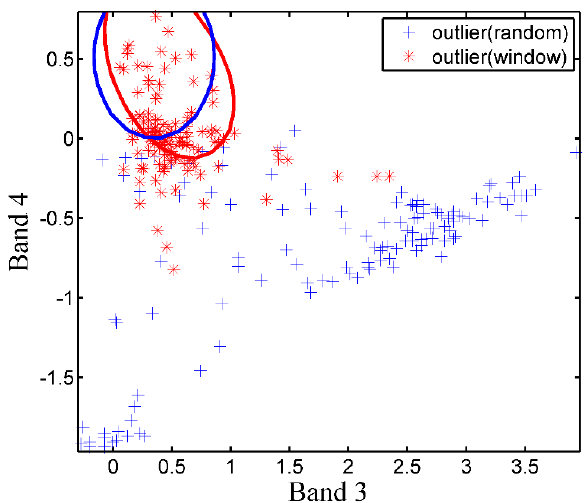
Figure 4. Hypersphere fitted by different validation sets. Red stars represent the validation data set derived from window-based method, and blue plus represents that from randomly selected method. Red ellipse represents hypersphere constructed by window-based test set while blue one by randomly selected test set.